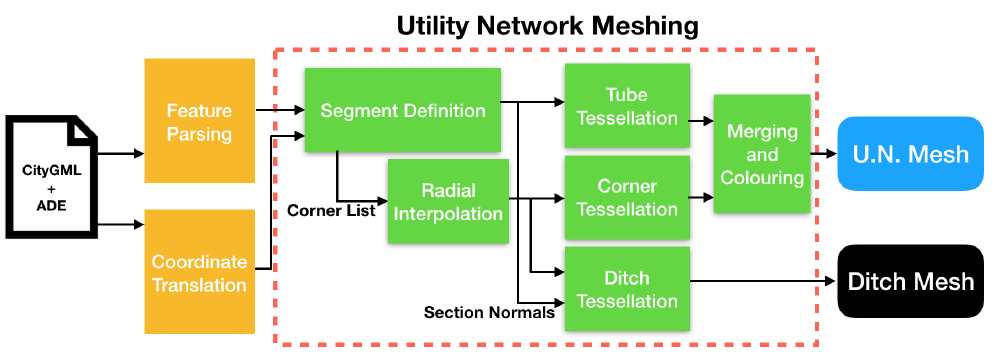
Figure 3. Flow chart of the utility network mesh generation process. RoundPipes are extracted from the CityGML model (orange) for a subsequent meshing (green). The process generates a list of straight segments and rounded corners that are tessellated independently. The final product is a set of tubular shapes signalizing the pipes (Utility Network Mesh) and surrounding black terrain trenches (Ditch Mesh). See Figure 10 for wireframe